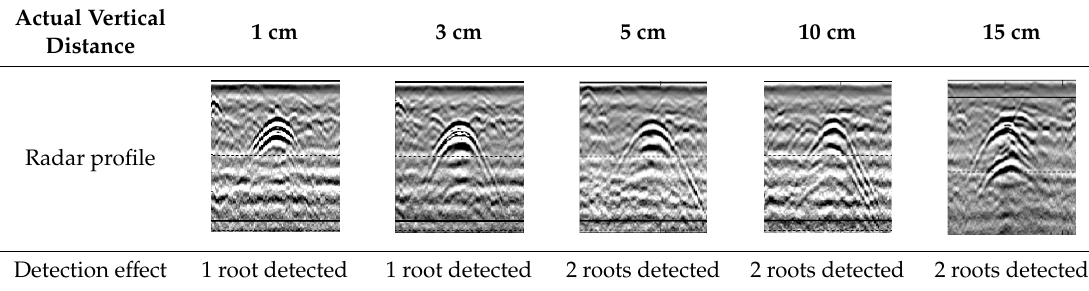
Table 5. Radar profiles of a root buried at different depths.